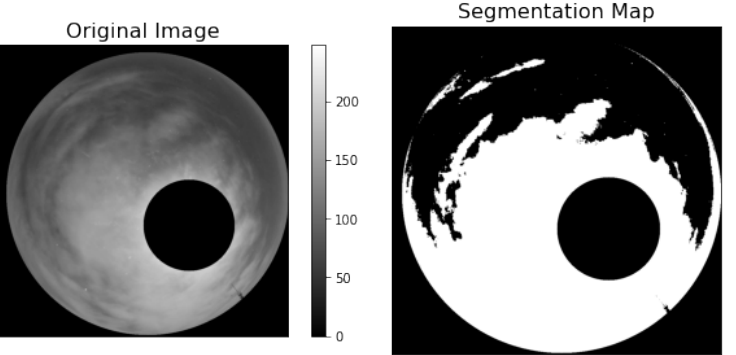
Figure 7. An example of the derived cloud segmentation map based on the adopted procedure described in Section 3.2.2 for the MIs. The black color represents the regions clear of clouds and masked Moon, while the white color corresponds to the regions covered by clouds.